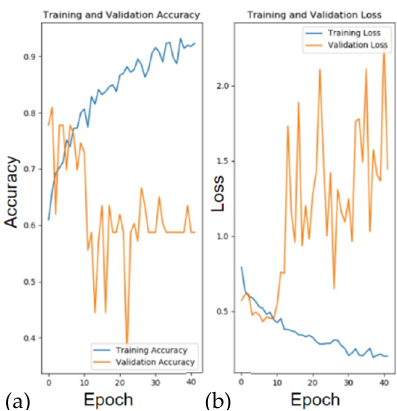
Figure 16. First results of a neural network. Graph (a) shows the accuracy of the model prediction. Graph (b) shows the value of the loss function.